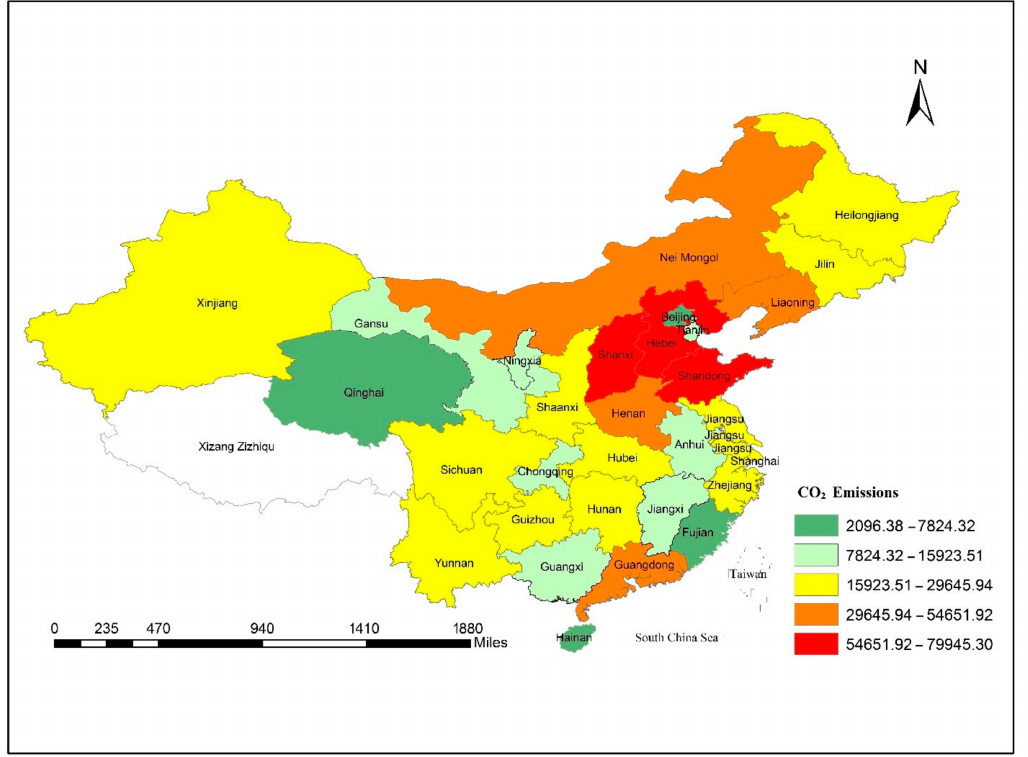
Figure 1. Spatial distribution of carbon dioxide emissions across the provinces of China,